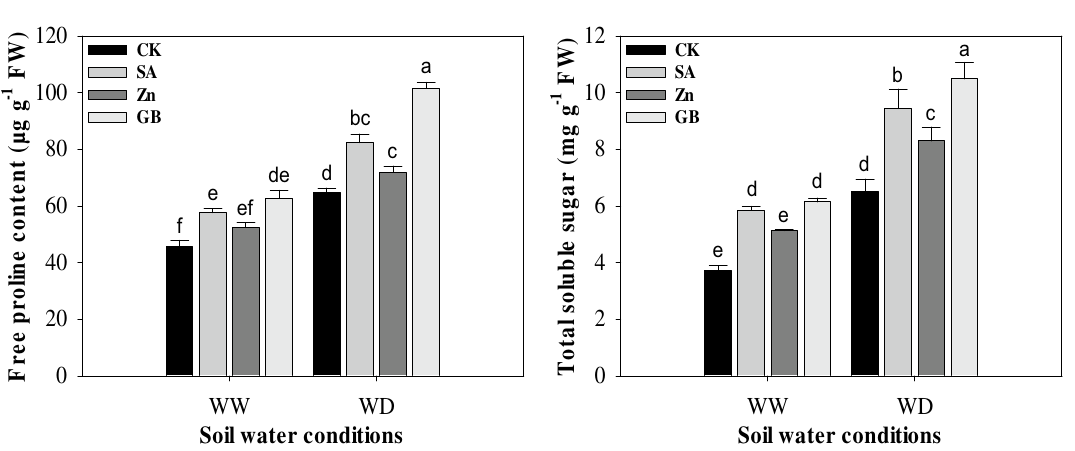
Figure 5. Effect of soil water conditions and foliar treatments on the accumulations of free proline content and total soluble sugar. Every column in each graph represents the mean (± SE) of three replicates. Different letters above columns indicate that means are different at 95% confidence level. WW, well-watered; WD, water- deficient; CK, control (double distilled water); SA, salicylic acid; Zn, Zinc; GB, Glycine